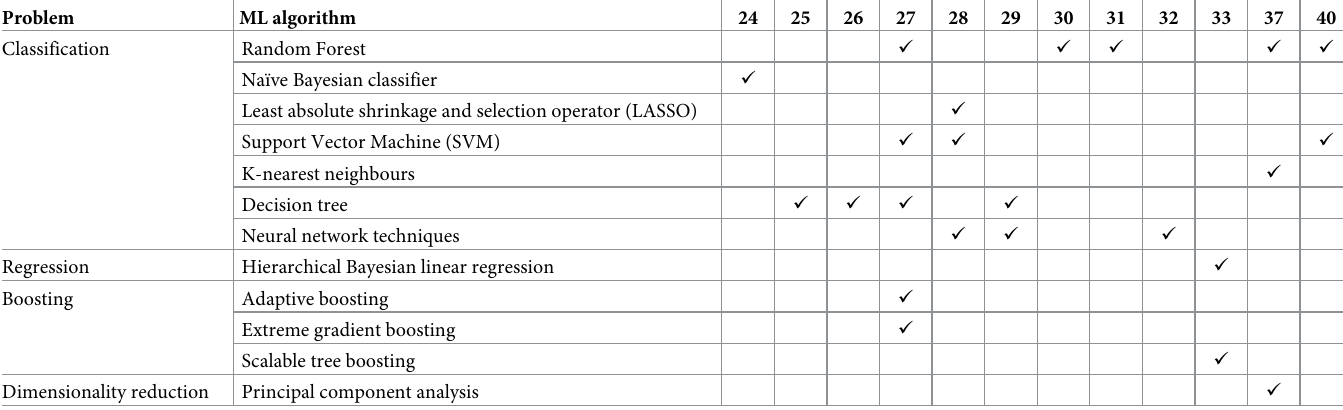
Table 5. Machine learning algorithms used in included